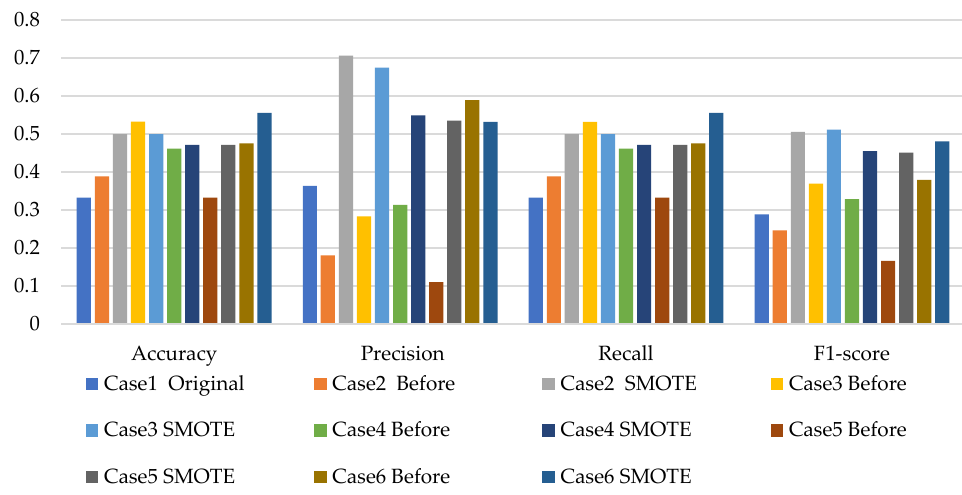
Figure 17. Experimental performance of SVM classification with SMOTE.